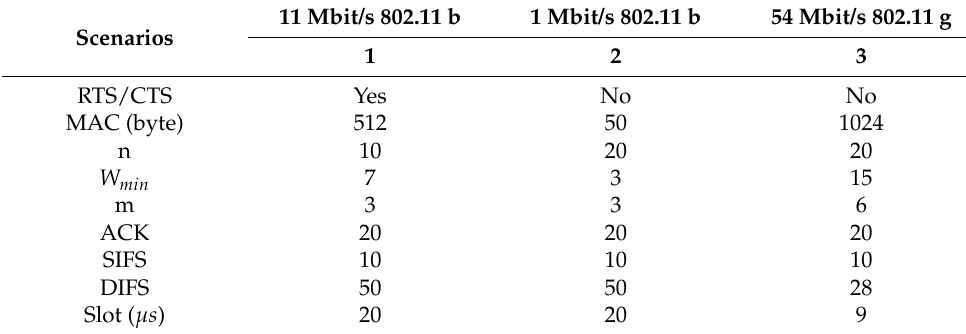
Table 2. DCF parameters in three different scenarios. Scenarios